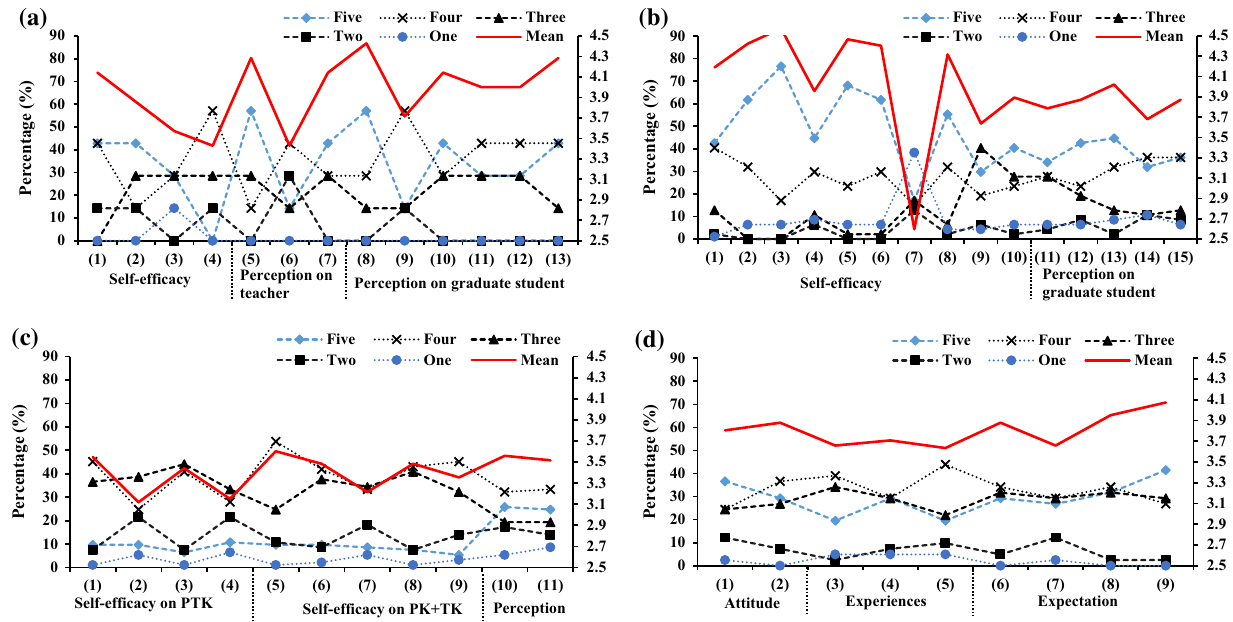
Fig. 6 The results of surveying: a from the program coordinator; b from the teacher; c from the graduate students; d from the undergradu- ate